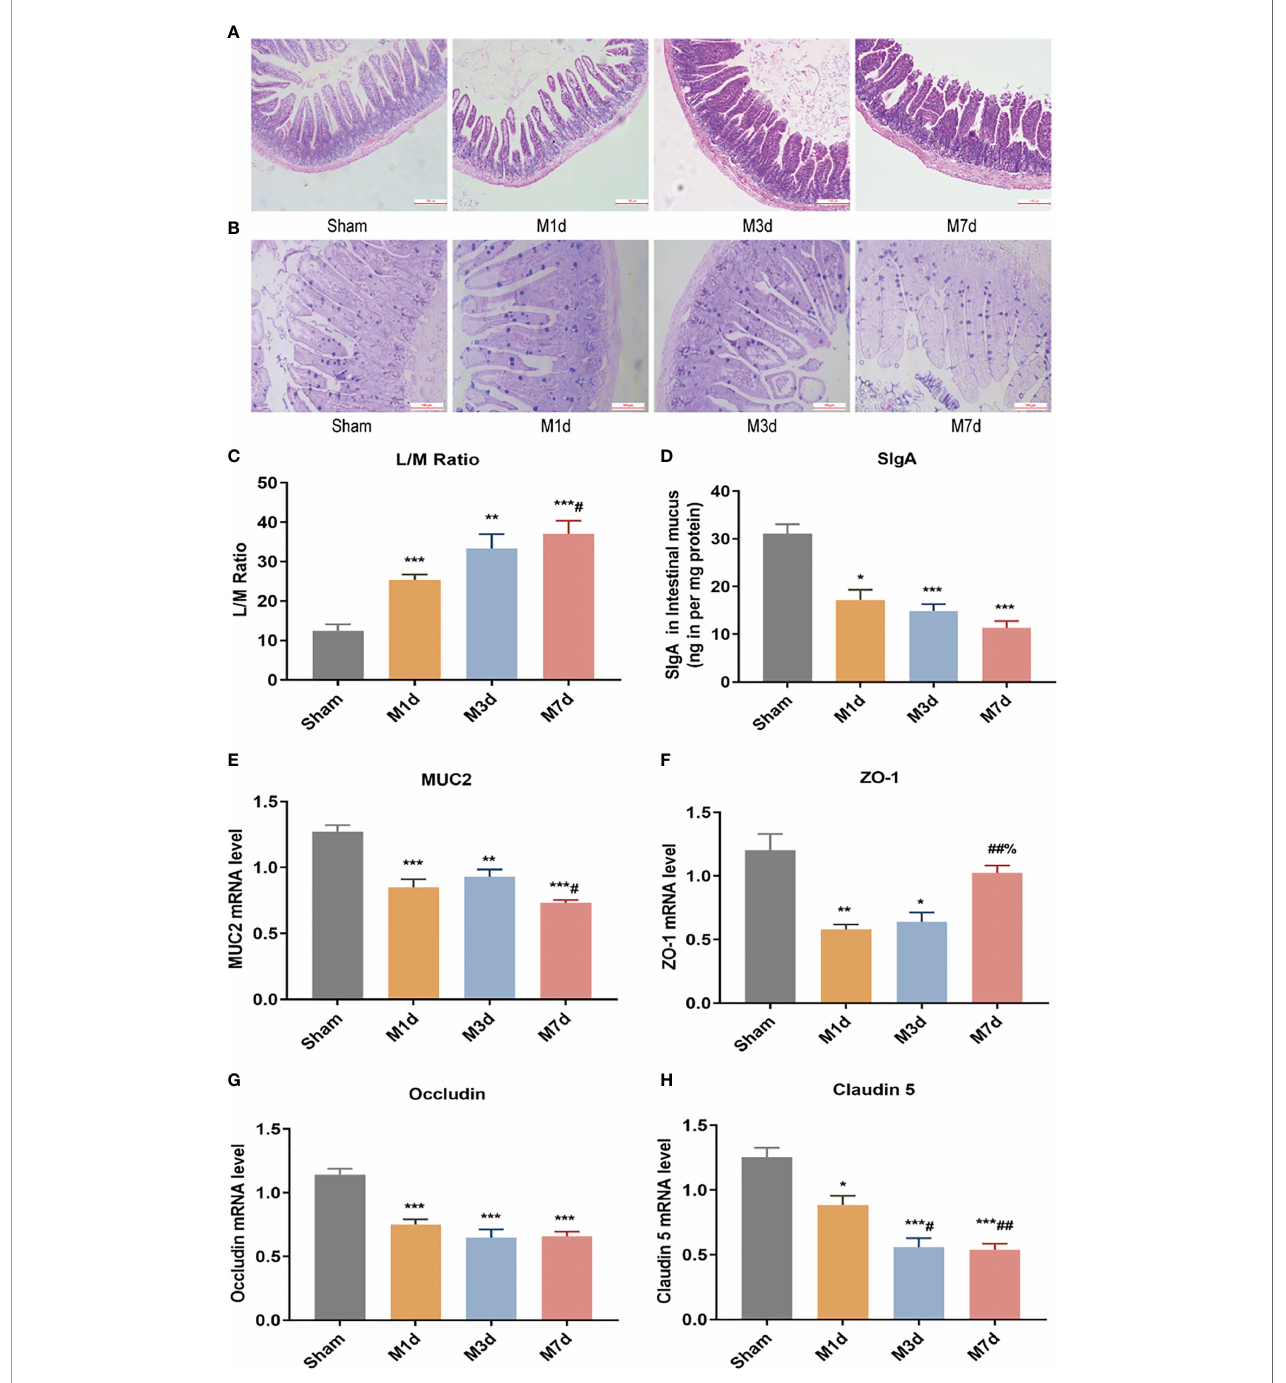
FIGURE 4 | Changes in intestinal barrier function in the ICH model at different time points. (A) Representative images of H&E staining of the ileum at different time points in the ICH model (magni fi cation ×100). (B) Representative images of PAS staining of the ileum at different time points in the ICH model (magni fi cation ×200). (C) L/M ratio, indicating changes in intestinal permeability at 1, 3 and 7 d following ICH (n=8). (D) Small intestine SigA level was quanti fi ed by ELISA at 1, 3 and 7 d following ICH (n=8). (E, F) The mRNA levels of MUC2, ZO-1, Occludin, and Claudin-5 were measured with RT-qPCR and normalized to GAPDH mRNA level (n = 8). Data are expressed as the mean ± standard deviation. (C) One-way ANOVA, Tukey ’ s multiple comparison test; (D, E) Brown-Forsythe test and Welch ’ s ANOVA, Dunnett ’ s T3 multiple comparison test; (F) Kruskal-Wallis ANOVA, Dunn ’ s multiple comparison test; (G, H) One-way ANOVA, Dunnett ’ s T3 multiple comparison test; * P <0.05, ** P <0.01, *** P <0.001 vs. the sham group; # P <0.05, ## P <0.01 vs. the M 1 d group; % P <0.05 vs. the M 3 d